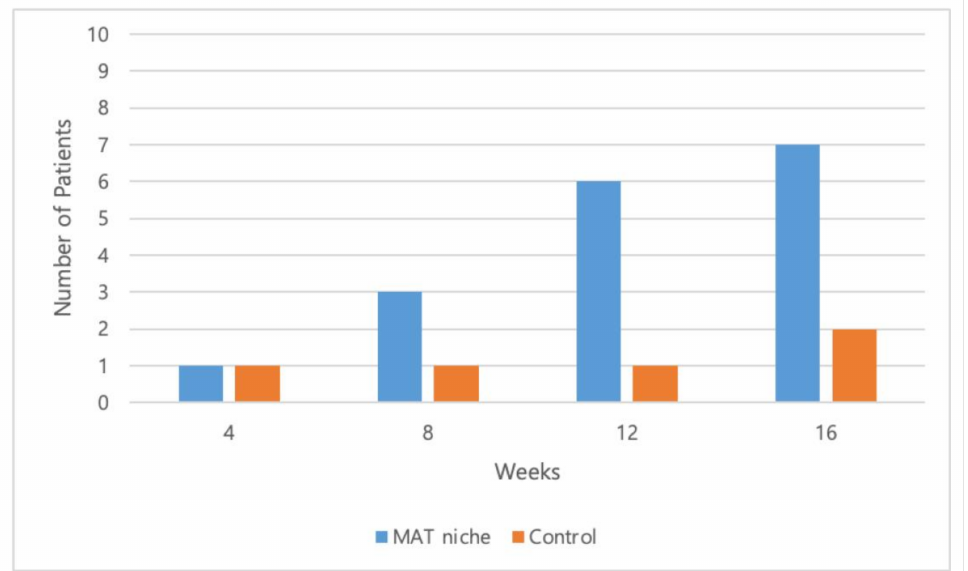
Figure 4. Total number of patients with completely closed wounds at 4, 8, 12, and 16 weeks. Complete wound closure was achieved in 10%, 40%, 70%, and 80% of patients in the treatment group and in